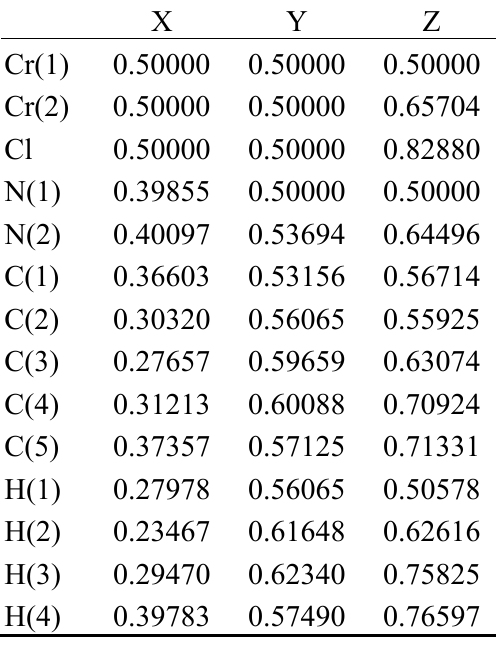
Figure 2. The modeling structure of Cr corresponding asymmetric unit with labeling. Table 1. Fractional coordinates of the asymmetric unit in Cr